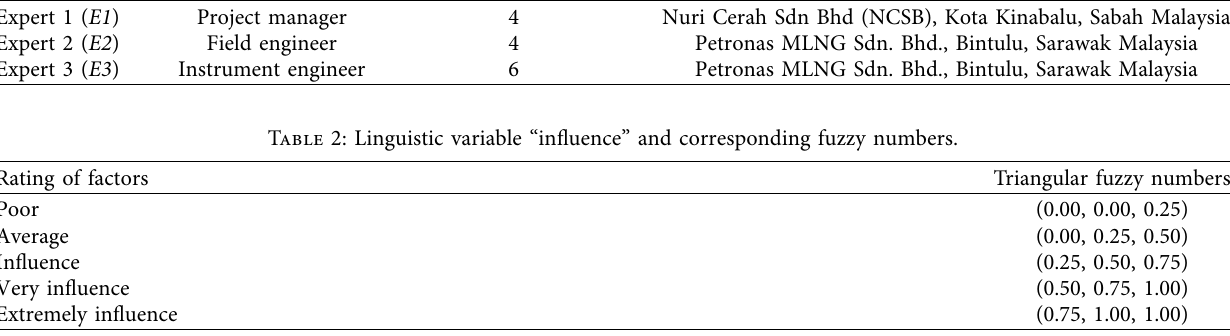
Table 3: Linguistic variable “importance” and corresponding fuzzy numbers.